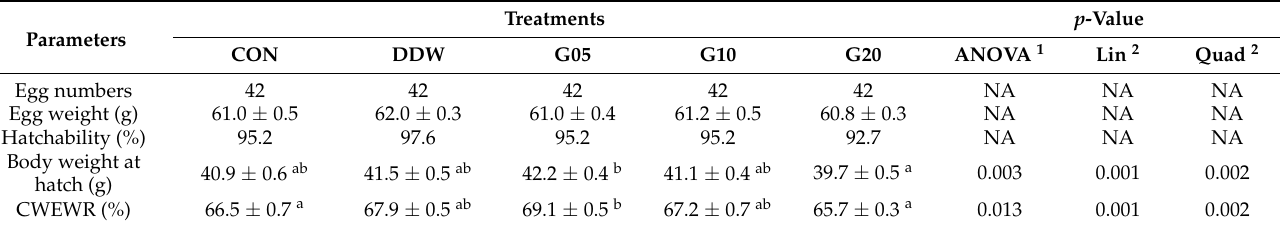
Table 2. Effects of in ovo administration of GABA on hatchability, chicks body weight at hatch, and chick weight to egg weight ratio.